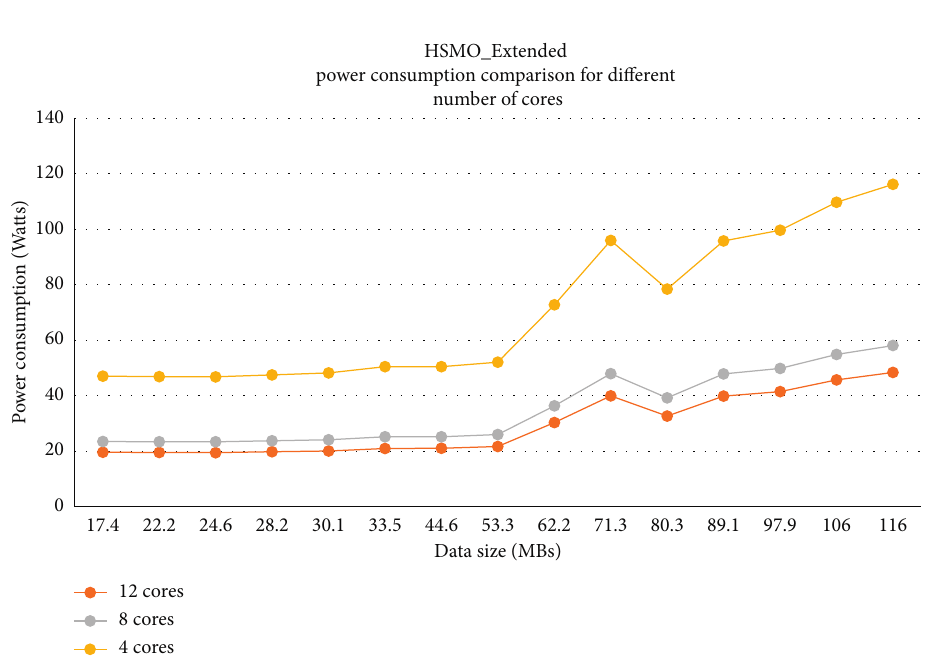
Figure 13: HSMO_Extended/power consumption comparison for different number of